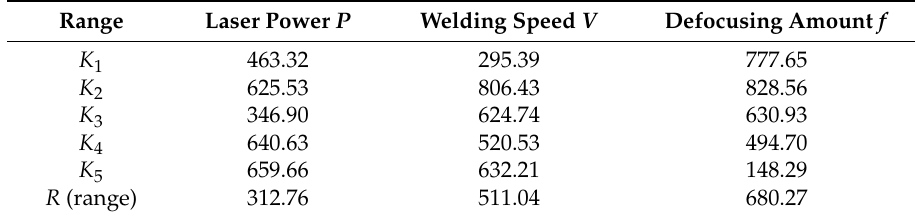
Table 2. Range analyzed results of orthogonal experiment.